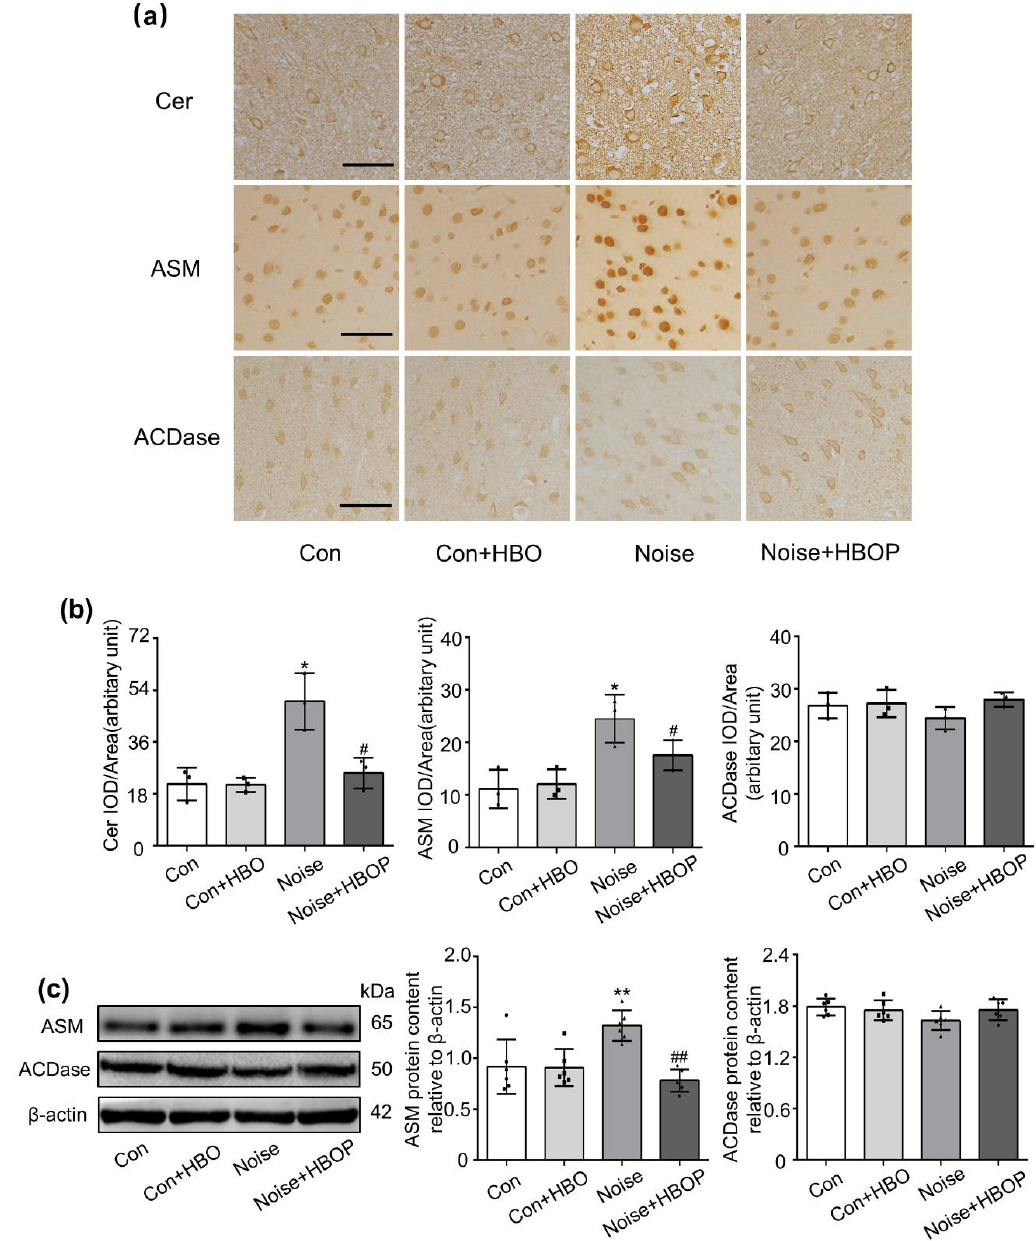
Figure 3. Representative images ( a ) and summarized data ( b ) showing the content of ceramide (Cer), acid sphingomyelinase (ASM) or acid ceramidase (ACDase) in auditory cortex of mice from Con or Noise group with or without hyperbaric oxygen treatment detected by IHC ( a ) and western blot ( c ) assay. Magnification × 400, scale bar = 50 µ m. Data are shown as means ± SD, n = 3 in IHC, n = 6 in western blot, ** P < 0.01, * P < 0.05 vs Con, ## P < 0.01, # P < 0.05 vs Noise. All individual data points were shown. All individual data points were shown in the figure using di ff erent shapes, • for Con group, (cid:4) for Con + HBO group, (cid:78) for Noise group, (cid:95) for Noise + HBOP